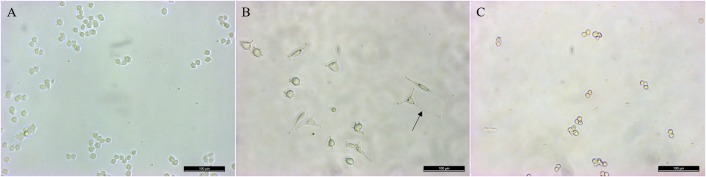
In vitro inhibition of the TrkA receptor in PC12 cells cultured with k-252a.(A) Non-treated cells (negative control). (B) Cells treated with 25 ng/mL rrβ-NGF (positive control). (C) Cells treated with K-252a+25 ng/mL rrβ-NGF. Arrow: neurite. Scale bar: 100 μm.